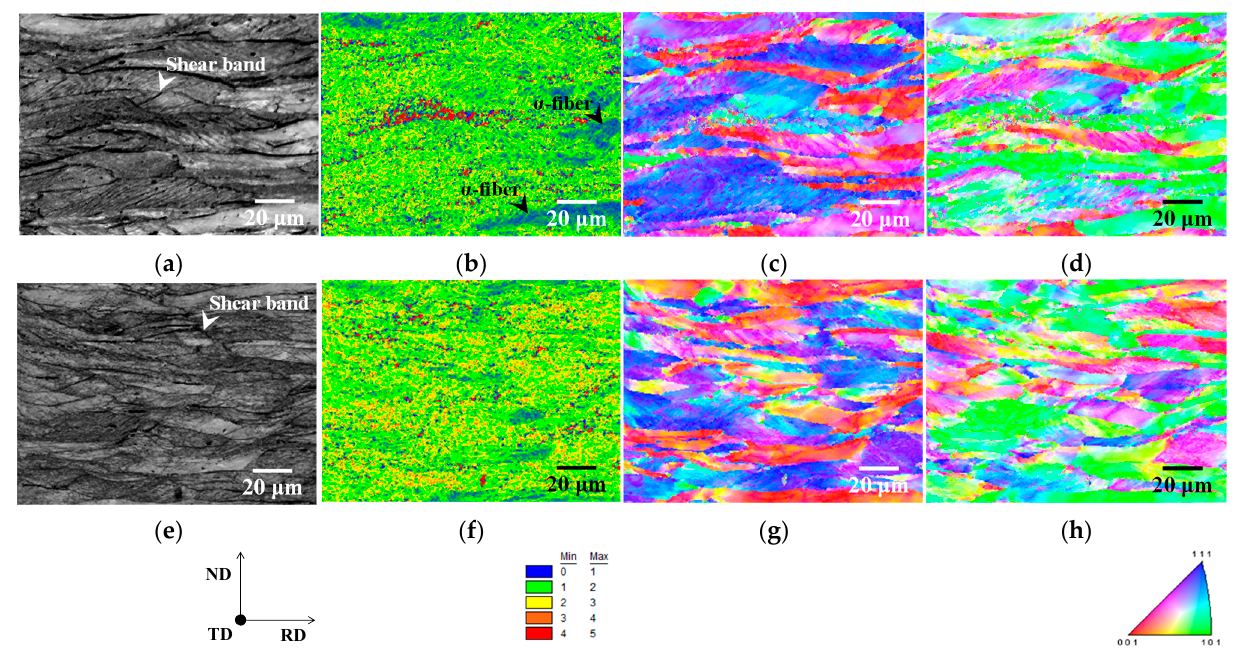
Figure 3. ( a , e ) Image quality, ( b , f ) kernel average misorientation, and inverse pole figure maps in the ( c , g ) normal and ( d , h ) rolling directions of cold-rolled specimens A and B.